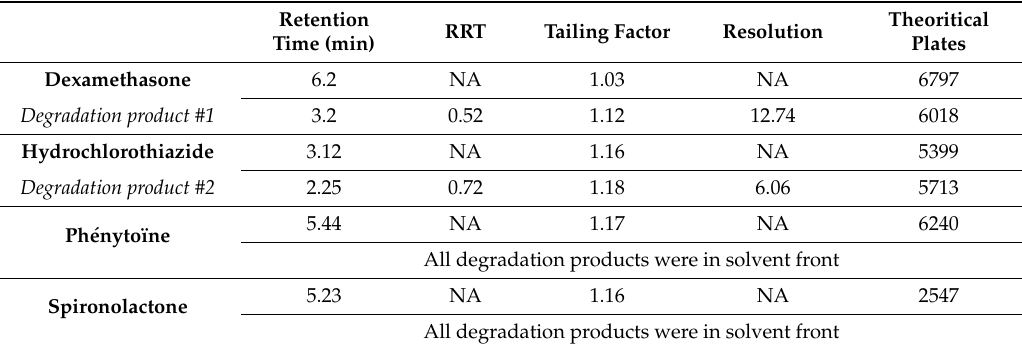
Table 4. Attributes related to three-dimensional chromatogram peaks obtained during a forced degradation study.